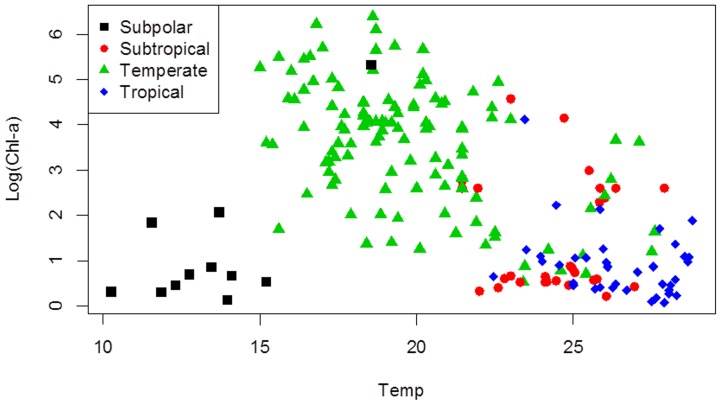
Bivariate scatter plot of environmental variables temperature (in °C), and chlorophyll-a (in log(µg L
−1)).Different climate zones are indicated with different colors.